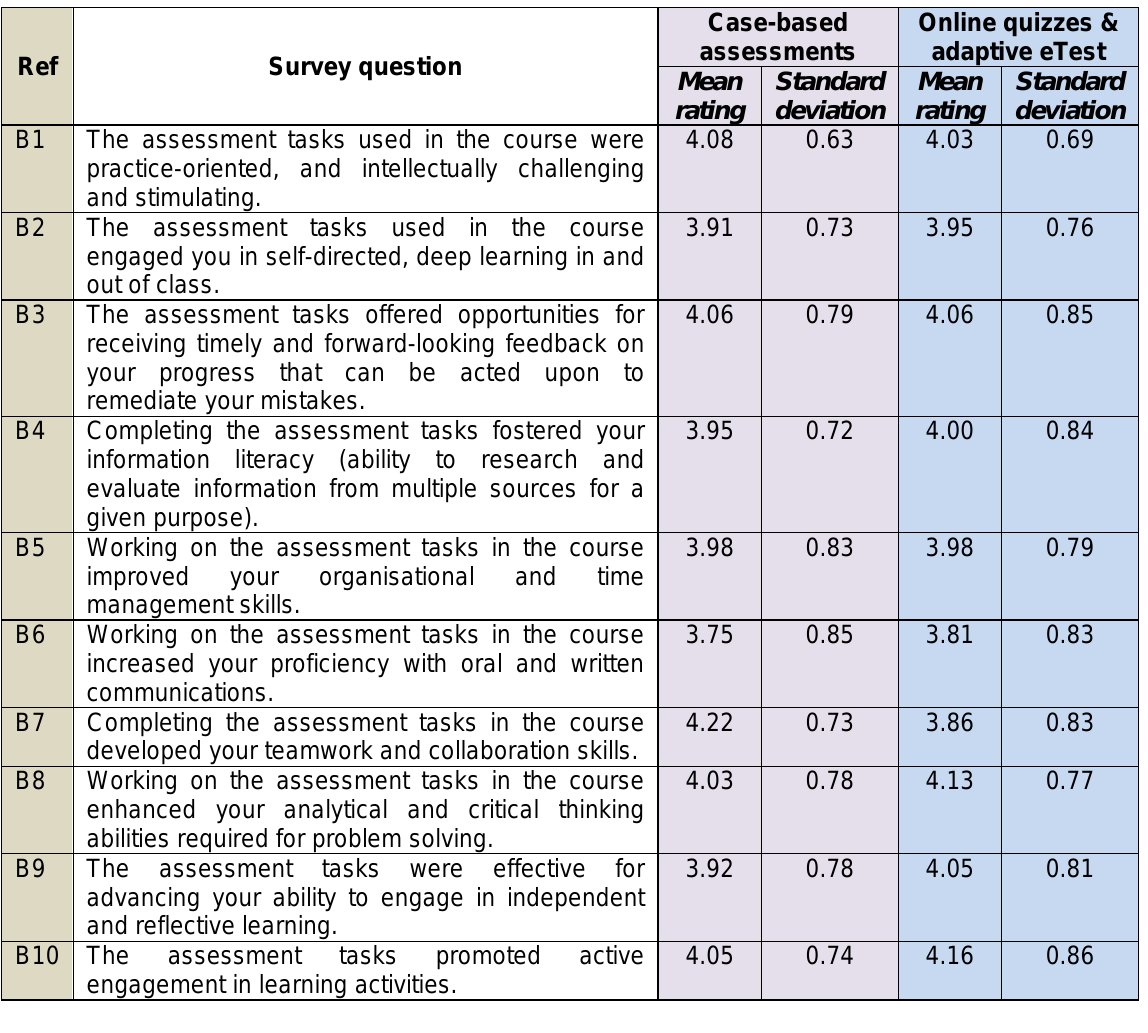
Case-based Online quizzes & assessments adaptive eTest Mean Standard Mean Standard rating deviation rating deviation